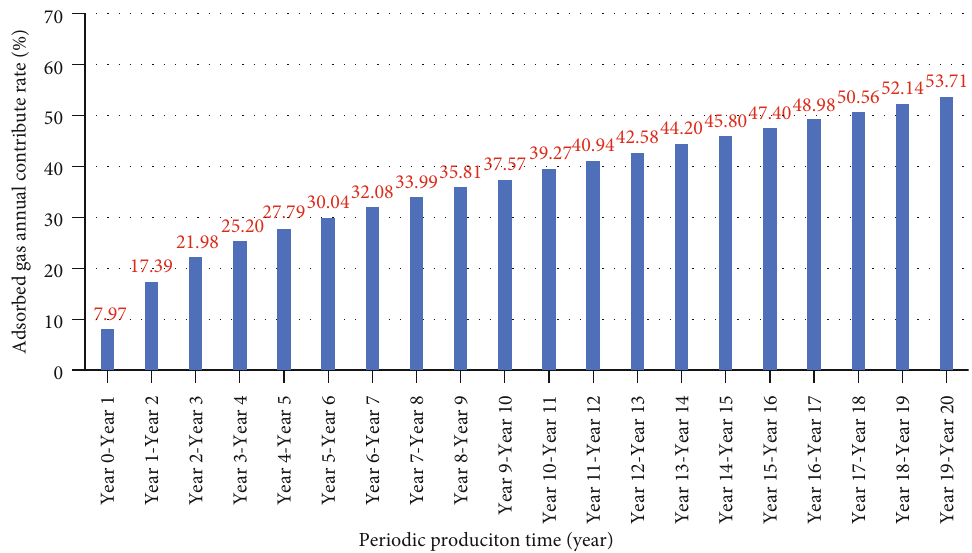
Figure 6: The adsorbed gas annual contribution rate versus the production time curve.